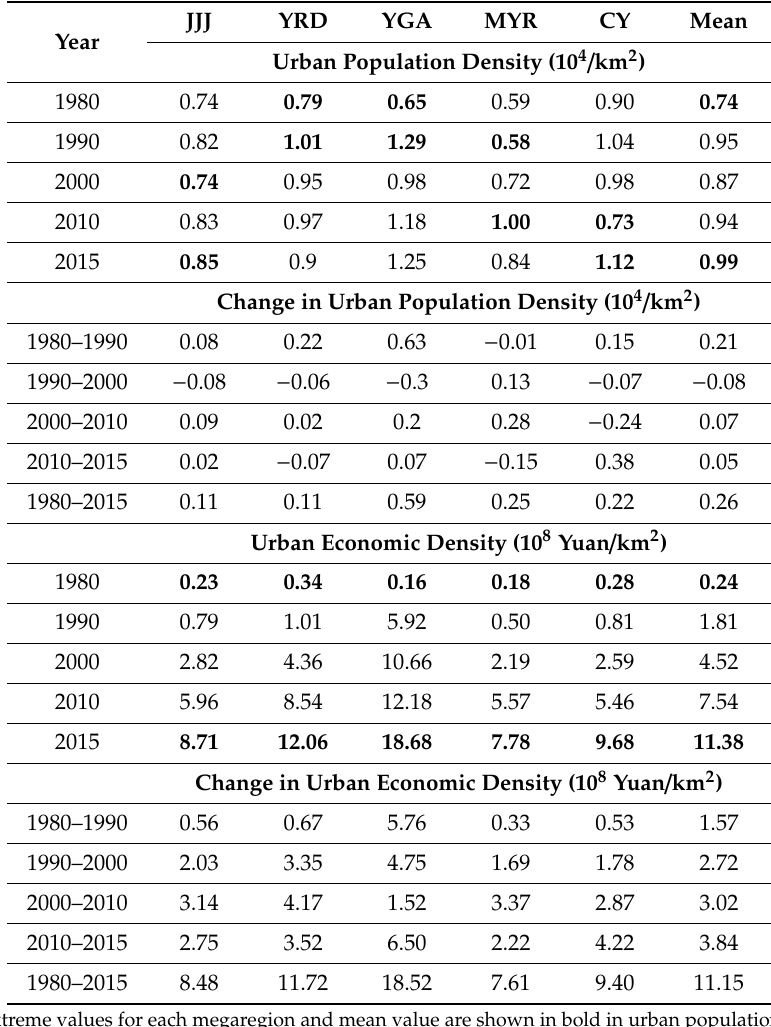
Table 4. Urban e ffi ciency density of di ff erent